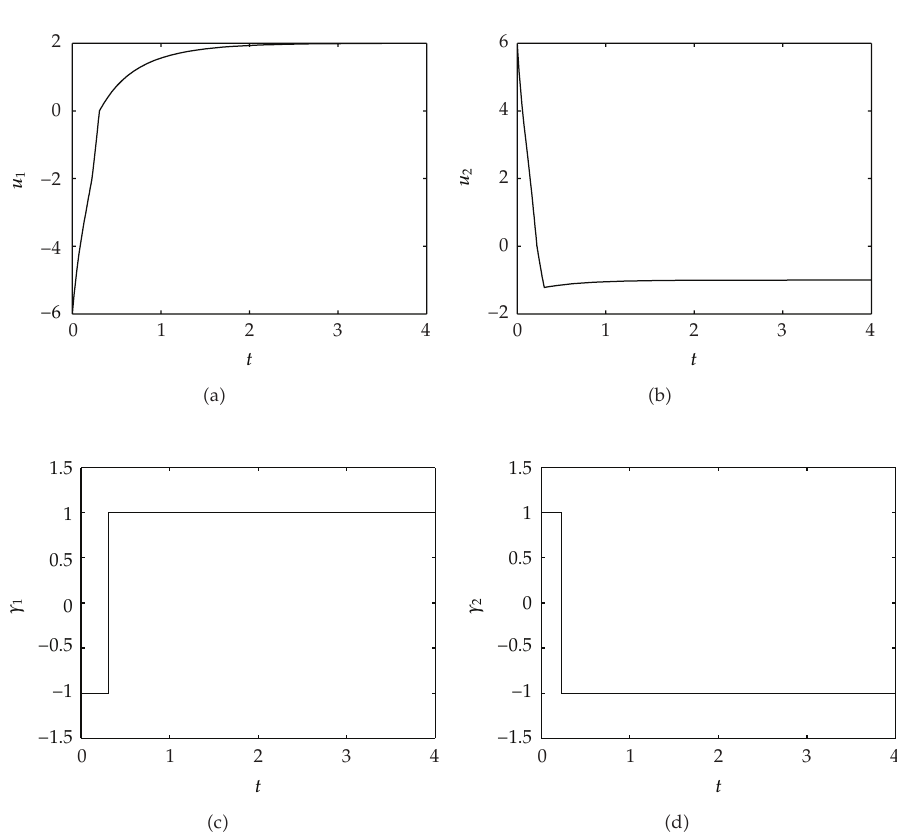
Figure 2: Transient behavior of (cid:5) u 1 ,u 2 (cid:6) and (cid:5) γ 1 ,γ 2 (cid:6) for I (cid:7) (cid:5) 0 , 0 (cid:6) T , u 0 (cid:7) (cid:5) 6 , − 6 (cid:6) T